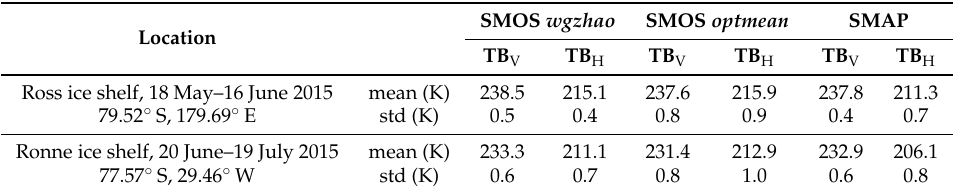
Figure 8. Brightness temperatures at vertical (top) and horizontal (bottom) polarizations over locations on the Ross ice shelf ( a ) and on the Ronne ice shelf ( b ). Data are shown during 30-day periods in 2015 with negligible trends. The different lines are SMOS data at θ = 40 ◦ produced using the weighted Zhao fit and a 5 ◦ -bin mean, as well as SMAP data. Table 3. Mean and standard deviations of 30-day time series over two ice shelves for polarized brightness temperatures (TB) from SMAP and from SMOS using the wgzhao and optmean fitting